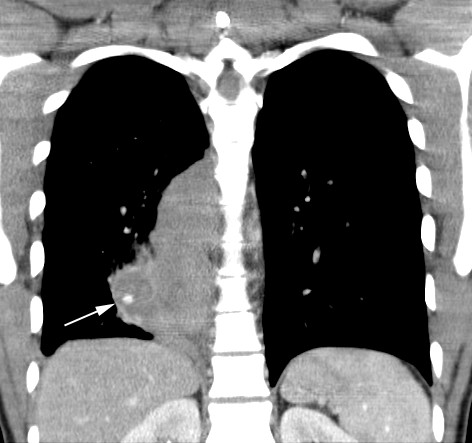
CT-reconstruction.